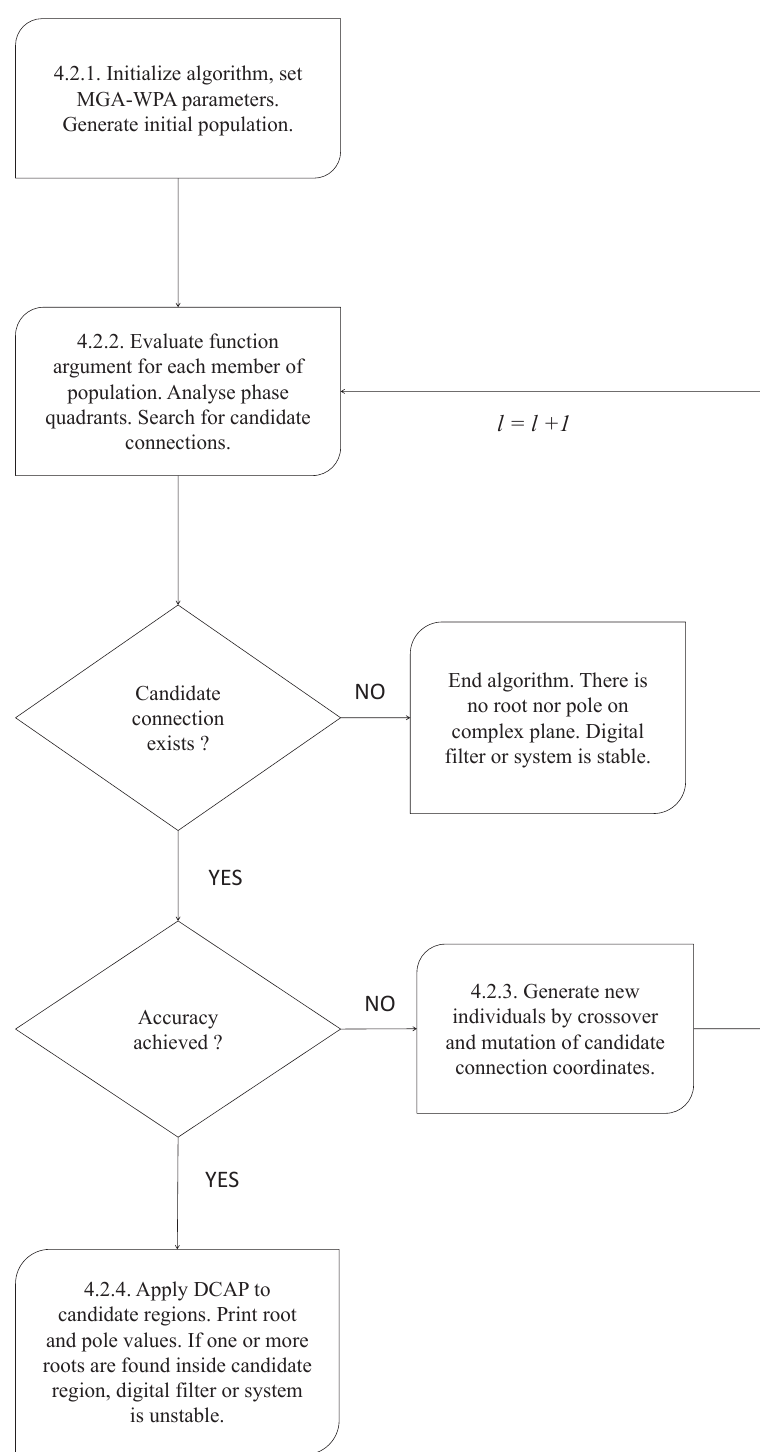
Figure 3. Flowchart of stability test with the multimodal genetic algorithm with phase analysis